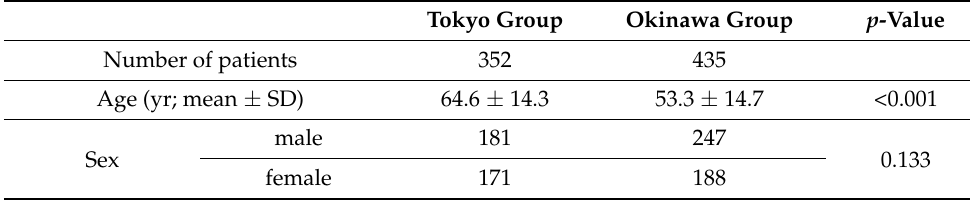
Figure 1. Flow diagram of the patients. Table 1. Baseline